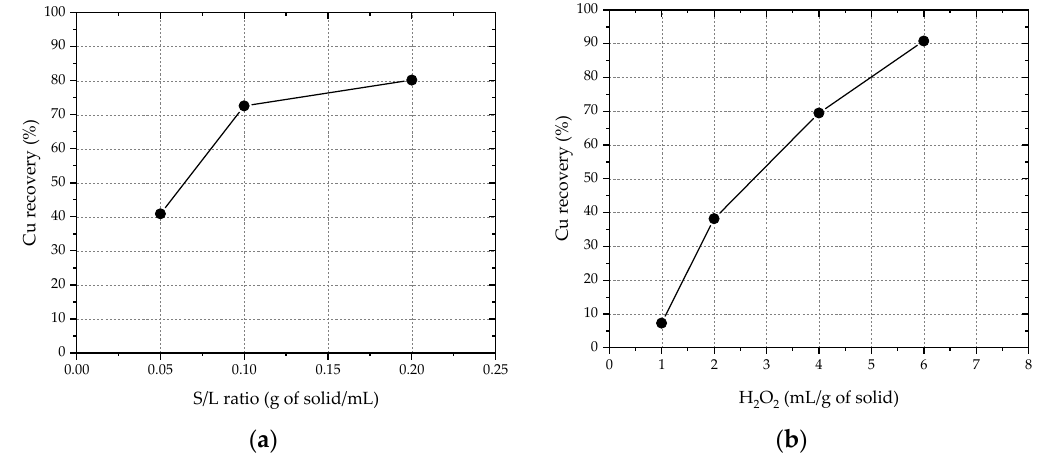
Figure 1. ( a ) Effect of the S/L ratio on Cu recovery, using 2 M H 2 SO 4 and 1 mL H 2 O 2 (30% w / w )/g of copper dust. ( b ) Effect of the H 2 O 2 concentration (mL of oxidant/g of dust) on Cu recovery, using 2 M H 2 SO 4 and an S/L ratio of 0.1 g/mL. Based on the results, the relatively optimum conditions for Cu were determined as